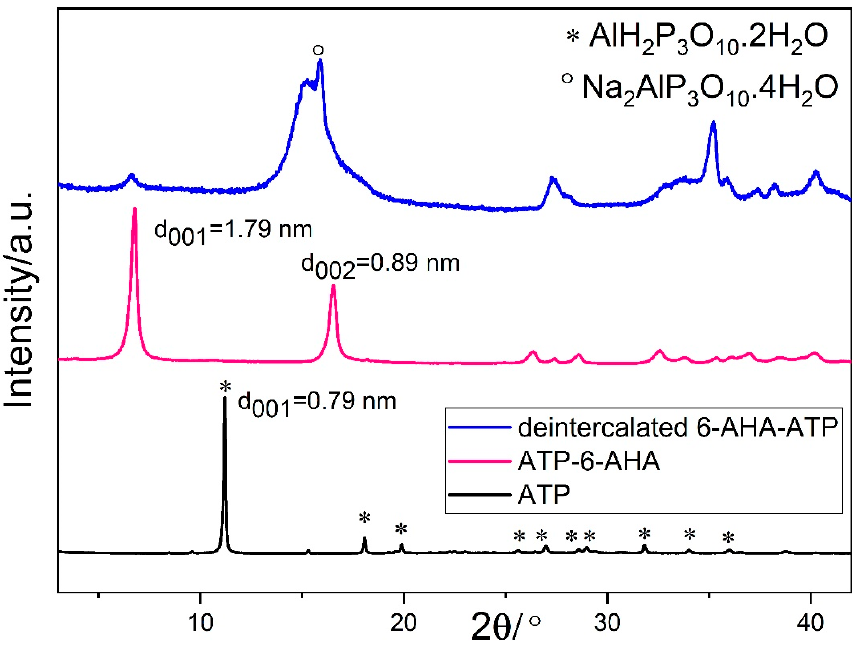
Figure 1. X-ray diffraction patterns of ATP ( bottom ), ATP-6-AHA ( middle ), and its deintercalated form Na 2 AlP 3 O 10 ⋅ 4H 2 O ( top ).